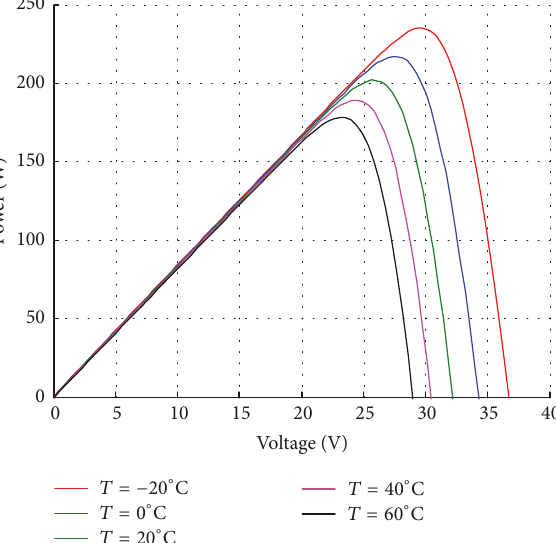
Figure 9: 𝑃 - 𝑉 curves for different cell